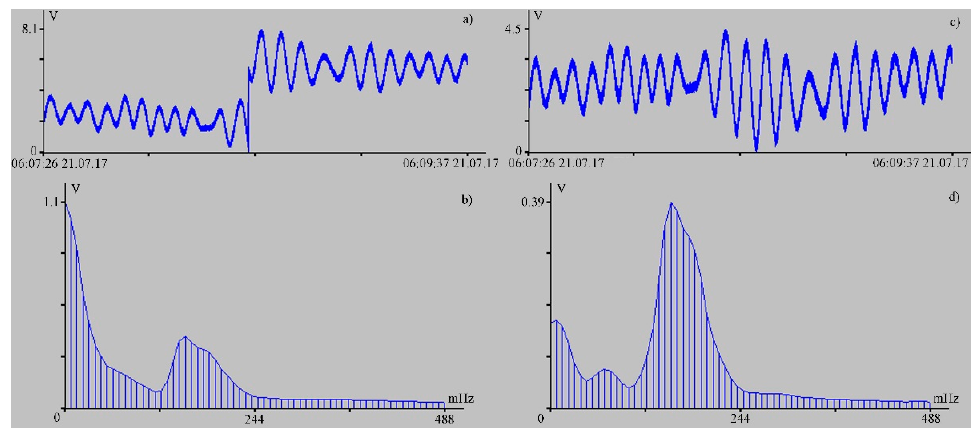
Figure 10. Fragment of the laser strainmeter recording showing hydrosphere pressure variations [21] when registering surface wind waves ( a ), along with its spectrum ( b ). The same recording is shown with the jump removed ( c ), along with its spectrum ( d ).